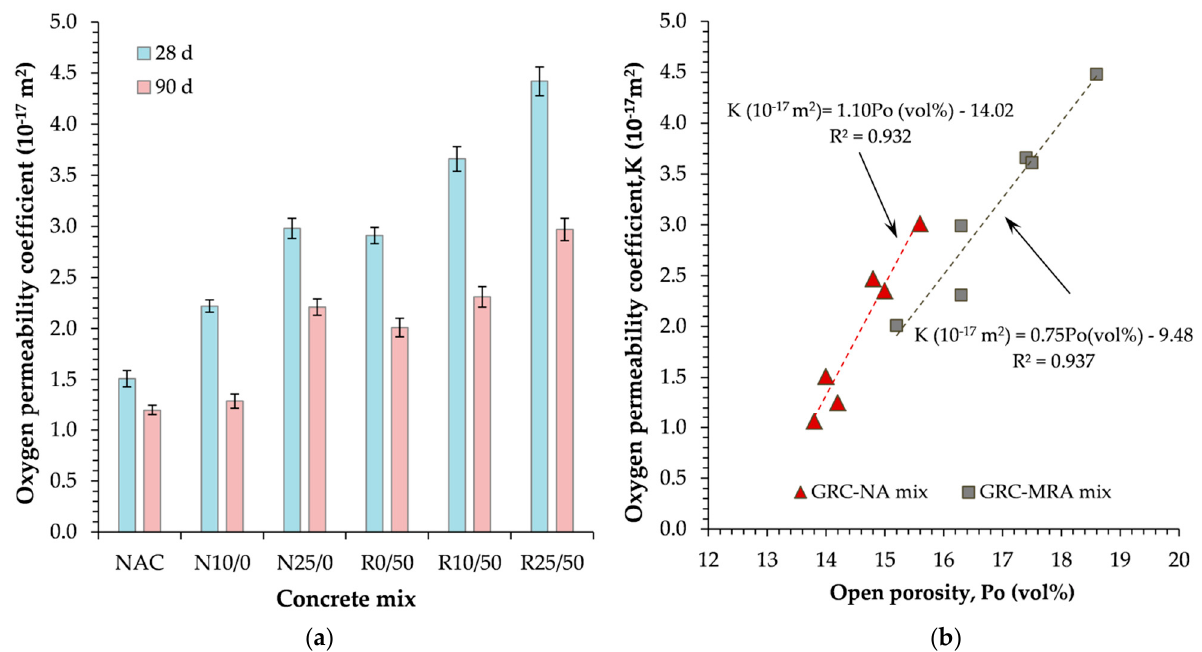
Figure 3. ( a ) 28 d and 90 d oxygen permeability (error bars indicate the standard deviation associated with variability in results); and ( b ) variation in open porosity with oxygen permeability.